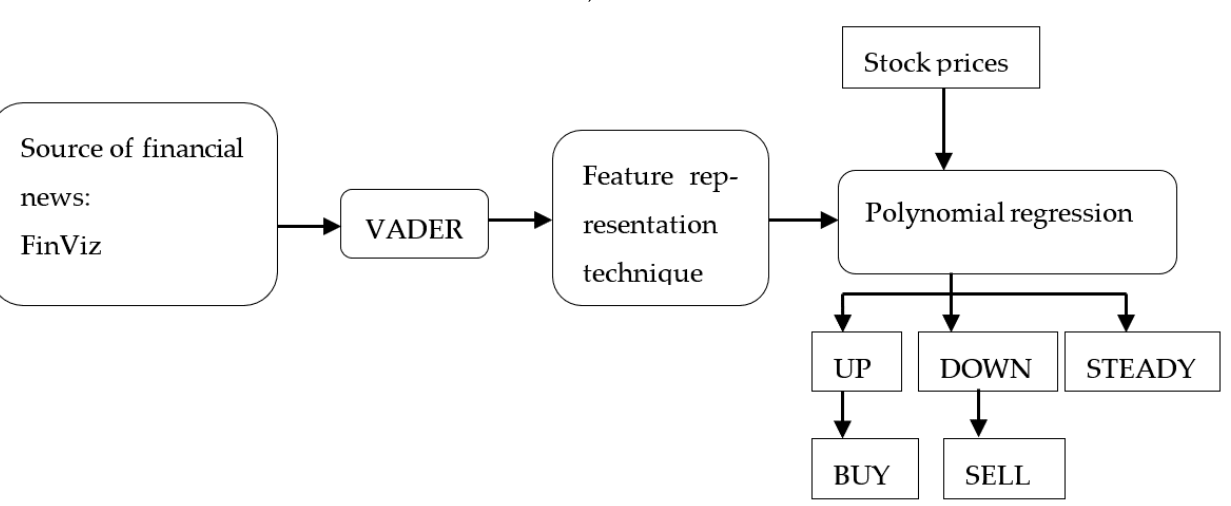
Figure 2. Research design.